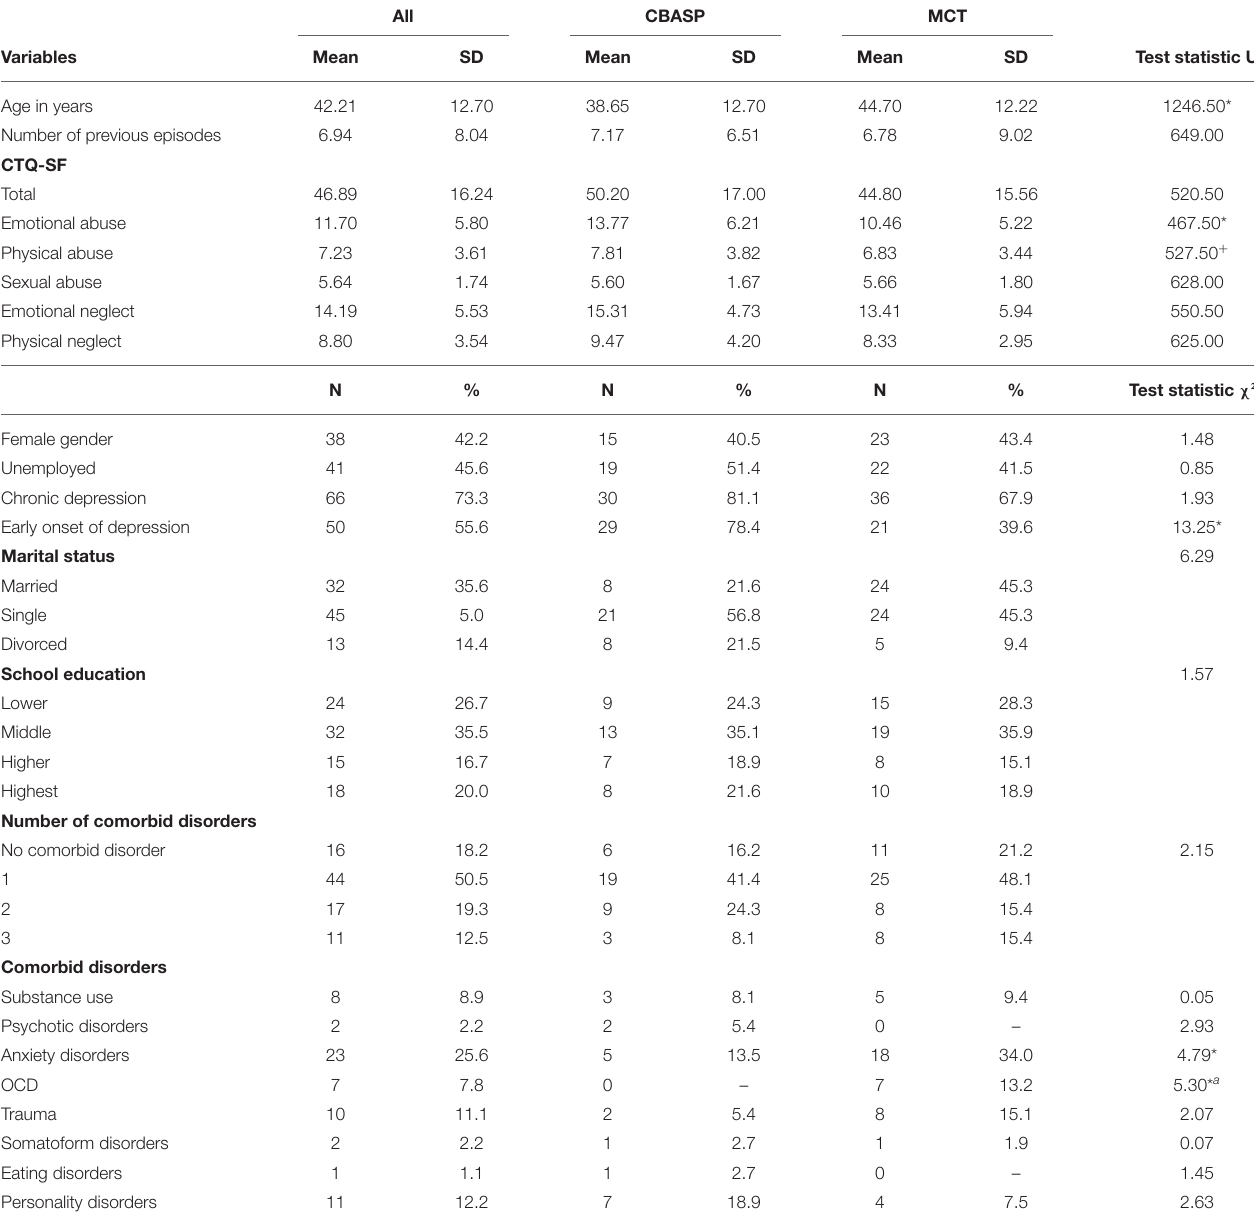
TABLE 1 | Demographic and clinical